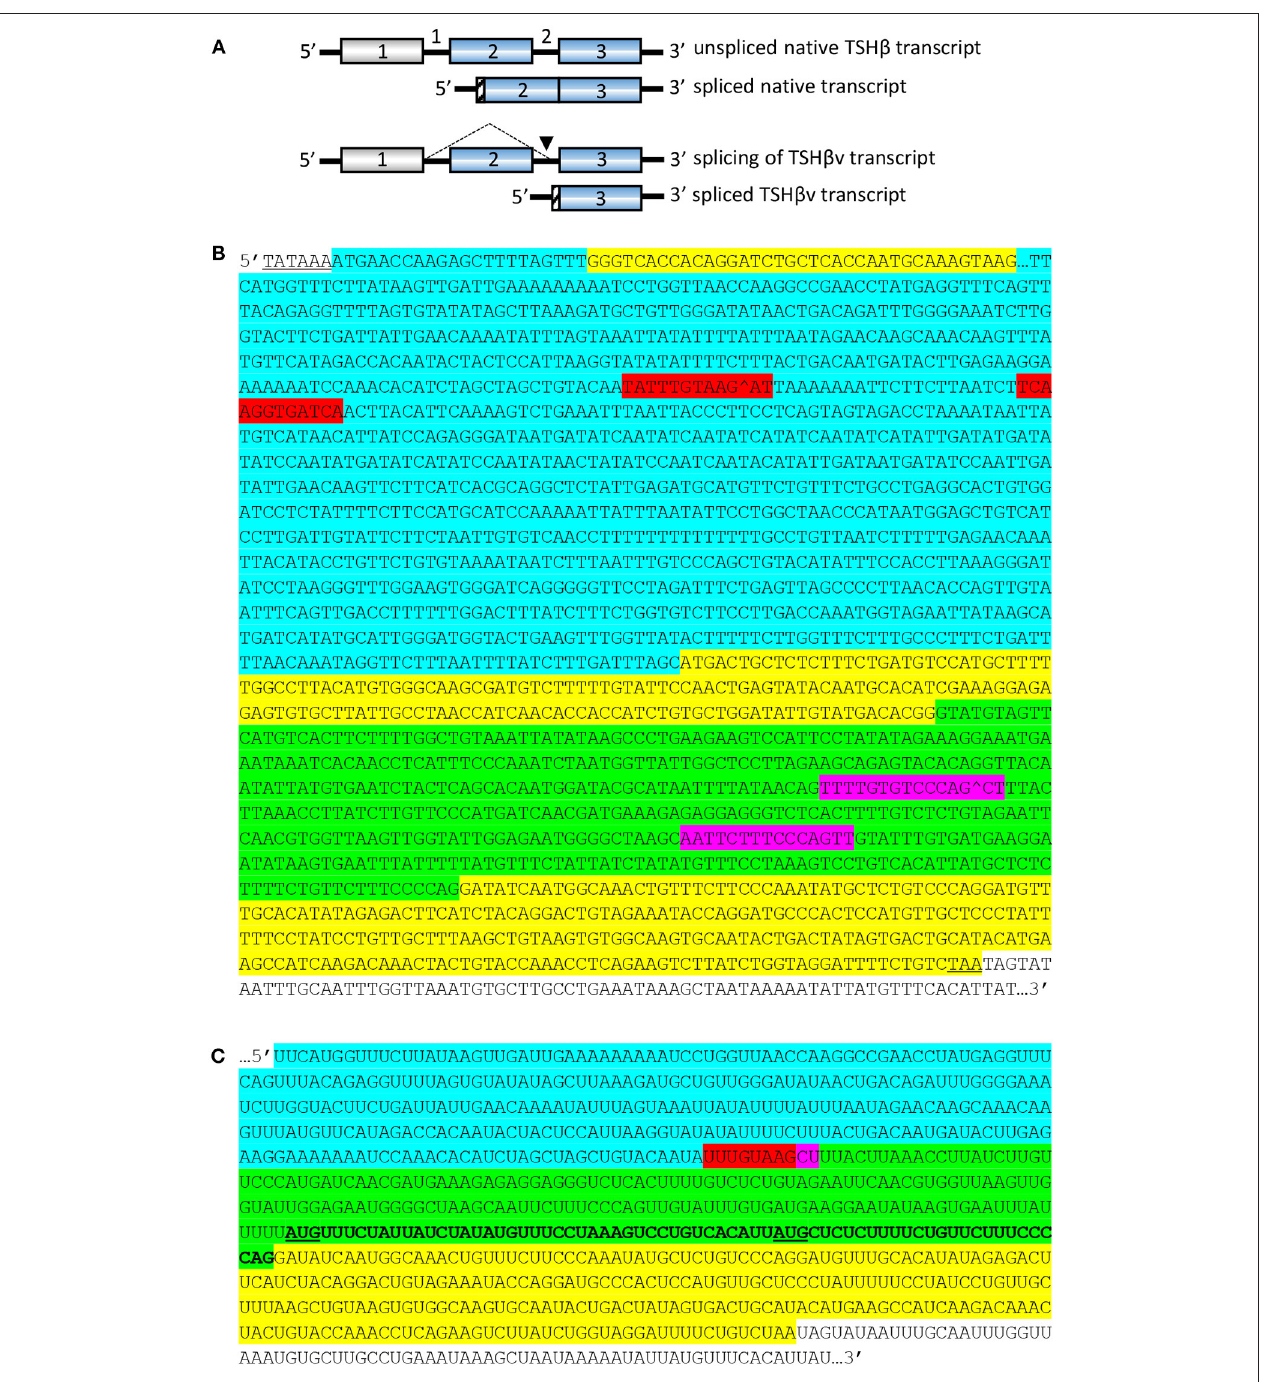
FIGURE 1 | Structural organization and splicing patterns of the native and splice variant forms of human tsh β transcripts. (A) The TSH β v transcript is produced by removal of the region coded for by exon 2, and splicing into the 3 ′ end of intron 2 (arrow), yielding a truncated TSH β transcript coded for by exon 3. Gray boxes are transcript regions from non-coding exons. Blue boxes are transcript regions from coding exons. Hatched regions code for signal peptides, which in native TSH β is at the beginning of exon 2, and in TSH β v is at the 3 ′ end of intron 2. (B) Unspliced TSH β . Gray underlined nucleotides, TATAAA hexamer box of transcriptional start site. Upper yellow nucleotides, exon 1. Blue nucleotides, portion of intron 1. Middle yellow nucleotides, exon 2. Green nucleotides, intron 2. Bottom yellow nucleotides, exon 3. Red nucleotides, potential splice donor sites. Purple nucleotides, potential splice acceptor sites. Underlined TAA, stop codon at end of exon 3. White nucleotides, untranslated portion of exon 3. Potential donor sites in intron 1: TATTTGTAAGAT, TCAAGGTGATCA; both with donor site scores ≥ 83.4. Potential acceptor sites in intron 2: TTTTGTGTCCCAGCT, AATTCTTTCCCAGTT; both with acceptor site scores ≥ 88.0. (C) Spliced human TSH β resulting in TSH β v transcript.